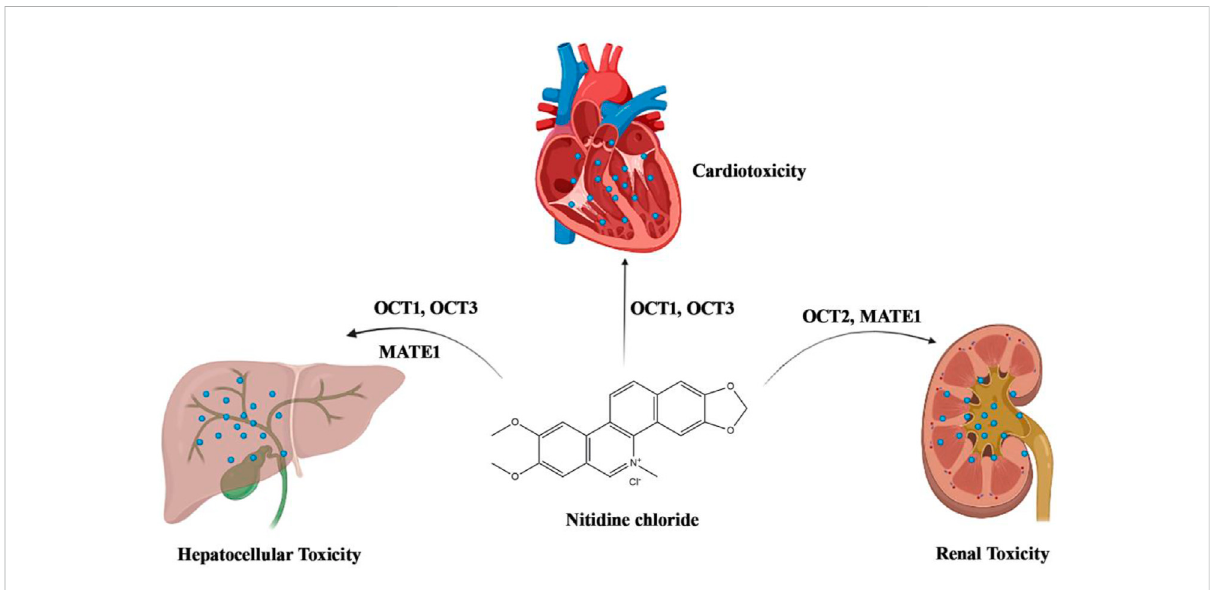
FIGURE 4 Toxic mechanisms of nitidine chloride on kidney, heart, and